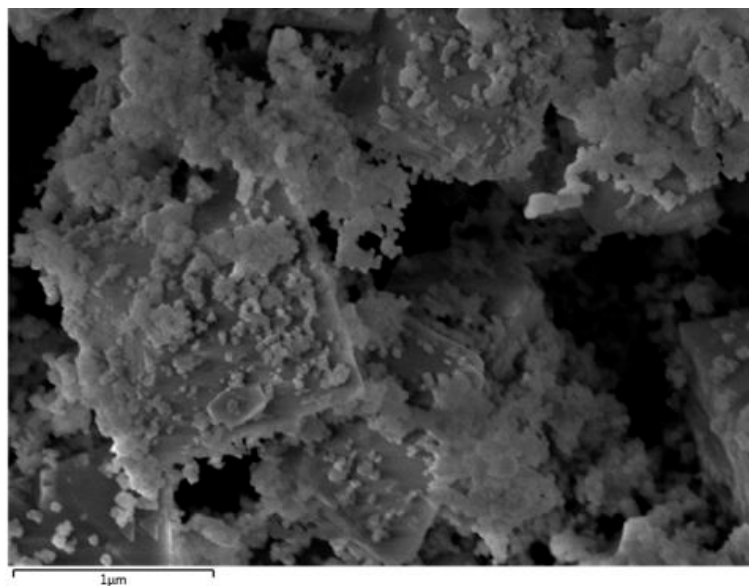
Figure 10. SEM micrograph of sample